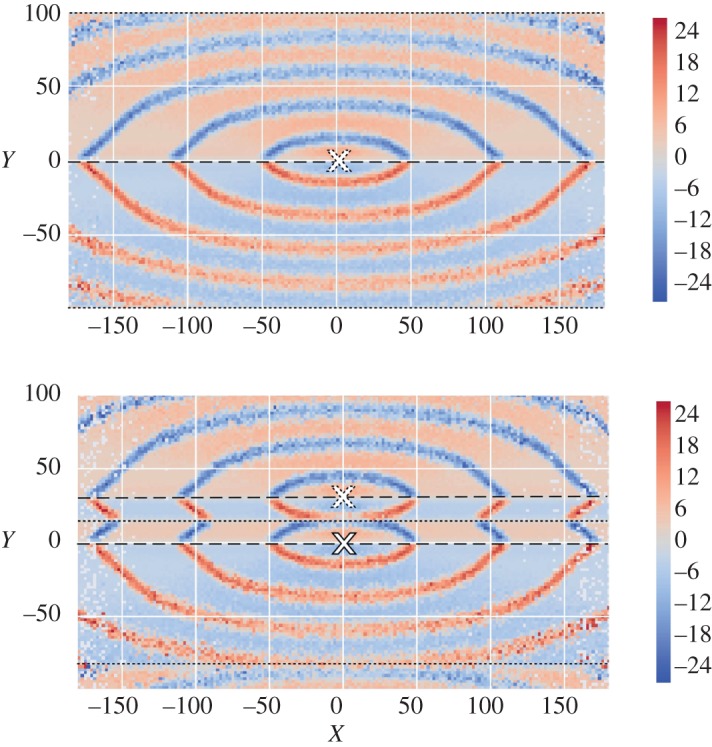
Vector feature maps for the mean vertical gradient across the electrode grid for the electrogram sampling start index. The above image has been created using the regular single rotor procedure illustrated in figure 9. The image below follows the same procedure but has been created from tissues with a second rotor at a fixed vector 30 cells above the initial rotor (note the image is generated from a smaller dataset which accounts for a small increase in noise compared to the above image). Rotor positions are indicated by white crosses. Wavefronts propagate away from the dashed lines and collide at the dotted lines, marking the boundary of a given rotor’s sphere of influence. The feature behaviour within a rotor’s sphere of influence (the regions up to the nearest dotted lines) in a double rotor system are almost identical to the dynamics observed in a single rotor system. The dotted line at the centre shows a sharp transition from the first rotor dynamics centred at (0,0) to the second rotor dynamics centred at (0,30). Note that the shift of the collision line from Y =±100 in the single rotor tissue to Y =−85 in the double rotor tissue can be exploited when searching for multiple rotors in a single tissue (figure 7).